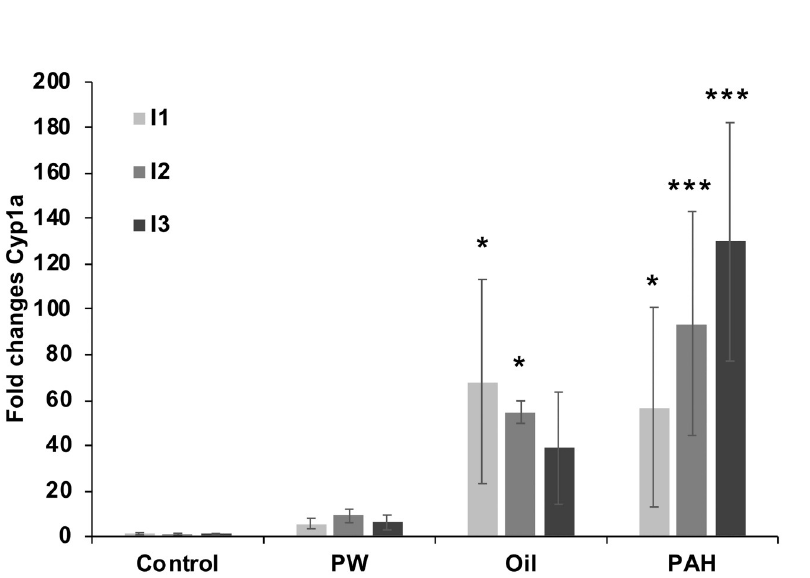
Fig 10. Gene expression of cyp1a in the intestine system of fish from the different treatments groups after 67 days of oral exposure to three exposure feeds; produced water ( PW , n = 4), oil fraction ( Oil , n = 4) and heavy PAH mixture ( PAH , n = 6) and a clean control feed (C, n = 5). Samples from the intestine system were sampled at 3 different positions (I1 = pyloric caeca, I2 = proximal intestine, I3 = distal intestine). Data presented as means ( ± SD). Asterisks indicate statistical difference relative to the control fish (ANOVA). P < 0.05 = � , P < 0.001 = ��� .